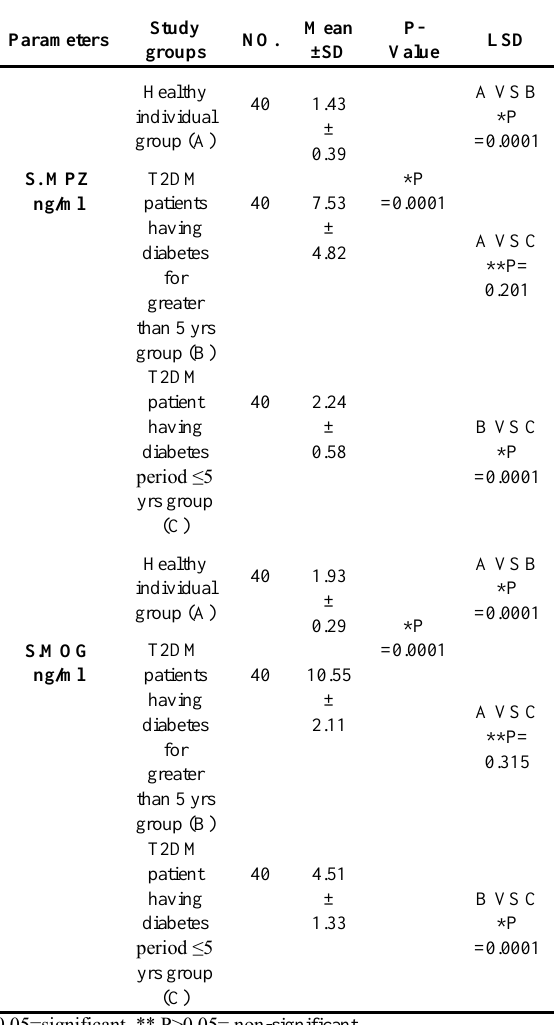
Table 2 : Mean ± Standard deviation (SD) of MPZ, and MOG in healthy individuals, and patient groups Parameters